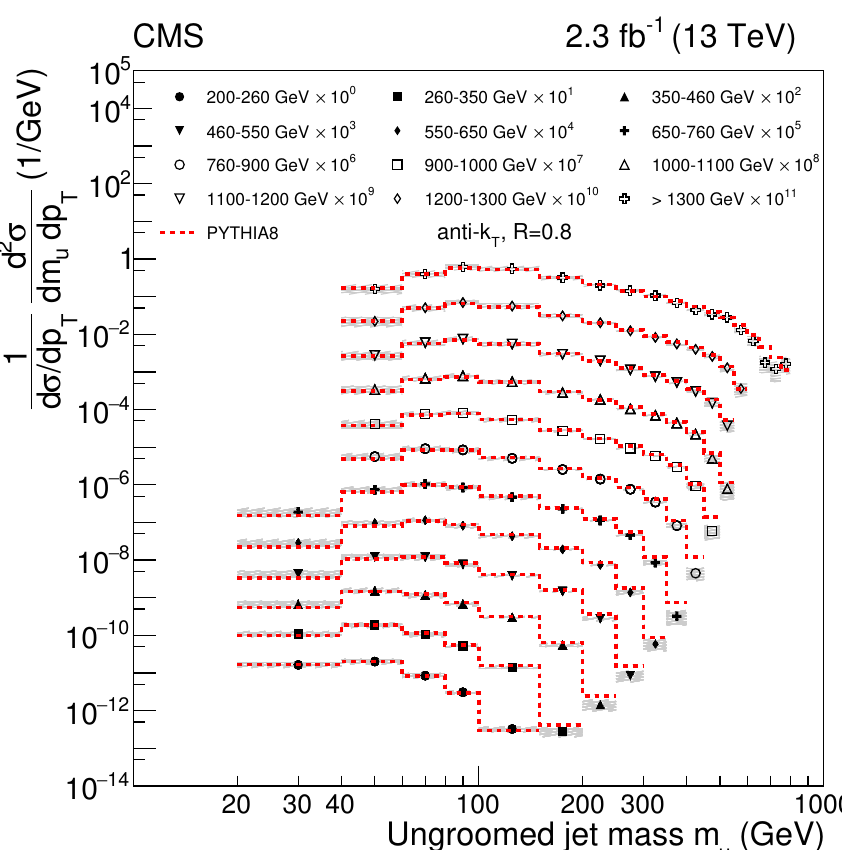
Figure 8 . Normalized cross section for ungroomed jets for all p T bins. Bins with statistical uncer- tainty larger than 60% are not shown. The data are shown with markers for each p T bin, scaled by a factor for better visibility. The total uncertainties (statistical added to systematic in quadrature) are shown with grey bands. The predictions from pythia 8 are shown as a dashed red